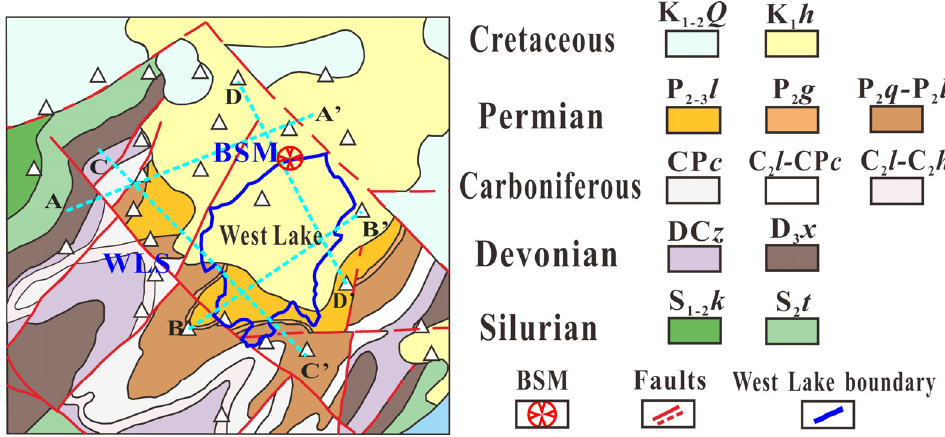
Figure 2. Simple geological map for the West Lake area with different strata denoted by different colors. The white triangles denote the seismic stations, with station WL.B04 marked. Cyan dashed lines denote locations of velocity cross-sections. The abbreviations are: Baoshi mountain (BSM), West Lake synclinorium (WLS).